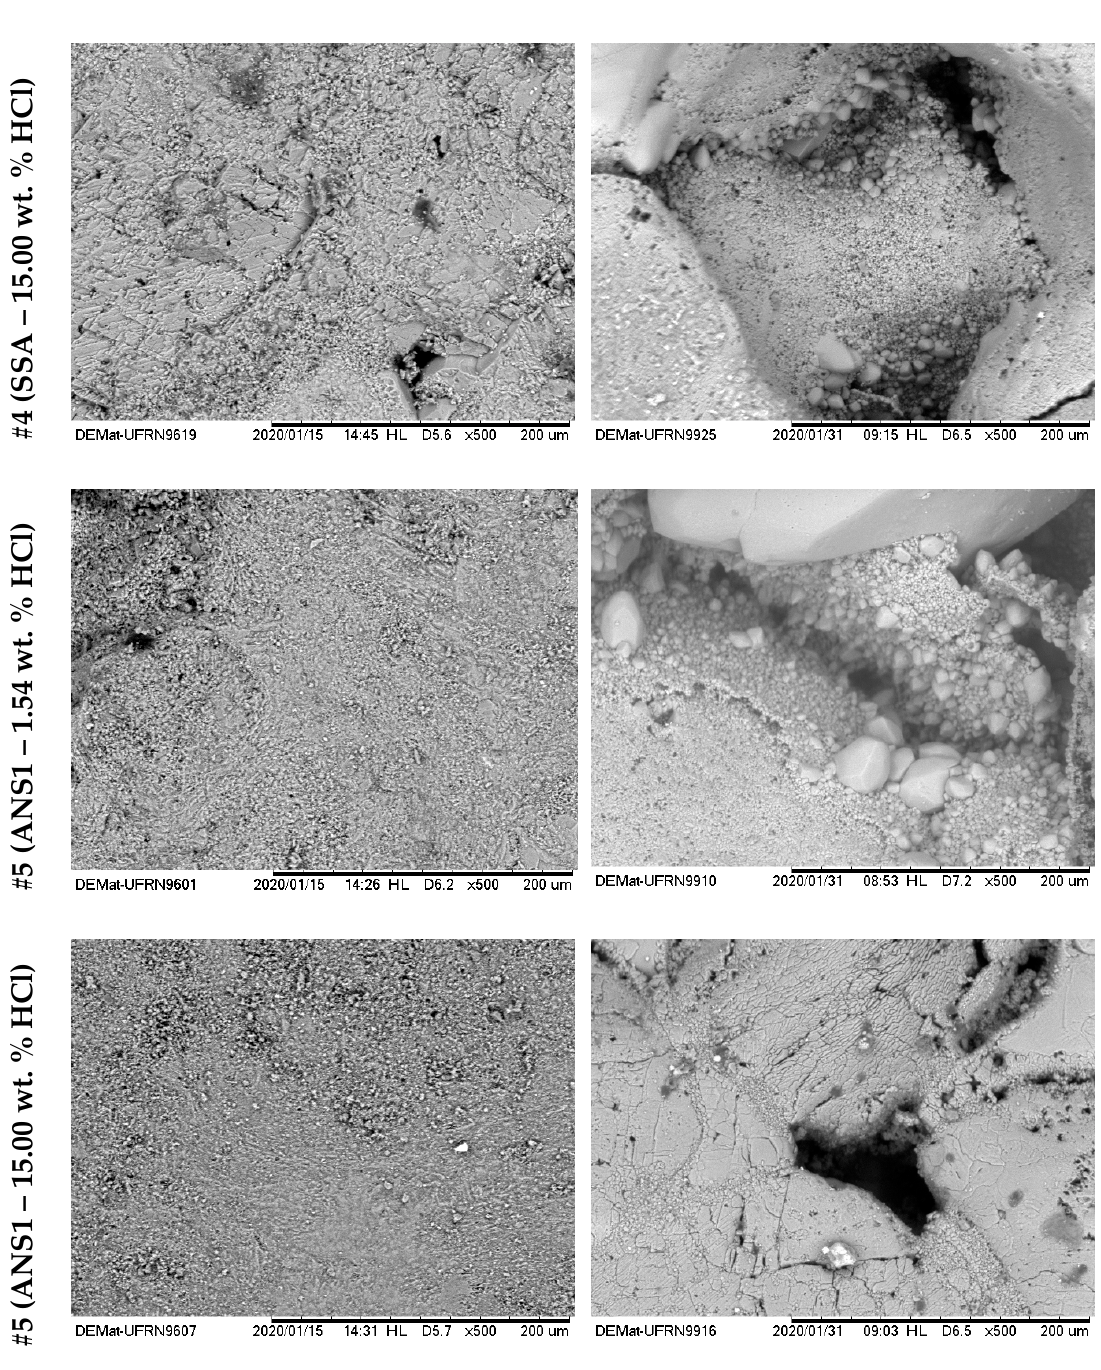
Figure 17. SEM photographs with 500 × magnification for systems SSA-15.00 wt. % HCl (#4), ANS1-1.54 wt. % HCl (#5) and ANS1-15.00 wt. % HCl (#6), before and after contact angle measurement in Indiana limestone.